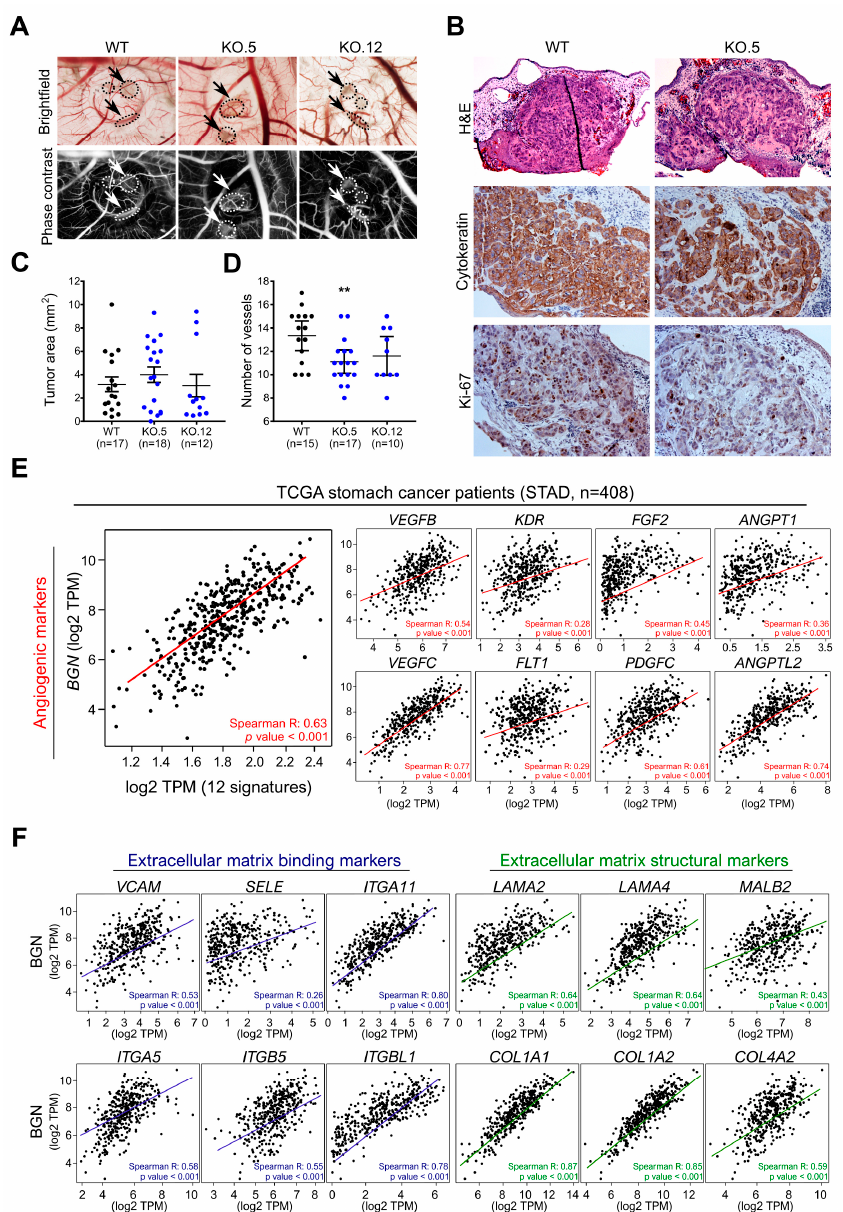
Figure 6. Effect of biglycan in in vivo angiogenesis. ( A ) Representative images of tumors formed in the in vivo CAM by MKN74 cell models (WT and biglycan KO clones—KO.5 and KO.12). Phase contrast was used to better visualize tumor foci and vessels. MKN74 form multiple tumor foci (arrows/circles). Magnification at 20×. ( B ) Histological images of the formed tumors, cytokeratin staining confirming the presence of human epithelial tumors in the CAM. Ki-67 expression analysis was used to assess tumor aggressiveness. Histologically, tumors formed by KO cells present a less cohesive-like tumor mass with increased extracellular matrix stiffness. Hematoxilin & Eosin (H&E) staining images at 100X magnification, cytokeration and Ki-67 images at 200× magnification. ( C ) Quantification of the tumor area (mm 2 ) with no significant differences in the tumors being derived from the different cell lines. ( D ) Number of new vessels (less than 20 µ m in diameter) formed towards the inoculation site. biglycan KO inoculated cells showed less capacity to form new vessels when compared to WT biglycan-positive tumors. ( E ) In silico gene analysis in GC tissues samples (TCGA, n = 408) showing that BGN was strongly positively correlated with angiogenic markers ( VEGFB, VEGFC, KDR, FLT1, FGF2, PDGFC, ANGPT1, ANGPT2, ANGPTL2, ANGPTL1, ANGPTL4, and ANGPTL7 ) . ( F ) In silico analysis demonstrating that BGN is positively correlated with ECM binding ( VCAM1, SELE, ITGA11, ITGA5, ITGB5, ITGBL1 ) and ECM structural ( LAMA2, LAMA4, LAMB2, COL1A1, COL1A2, and COL4A2 ) genes in GC samples (TCGA, n = 408). Gene correlation was performed using the Gene Expression Profiling Interactive Analysis (GEPIA) program. **, p value <